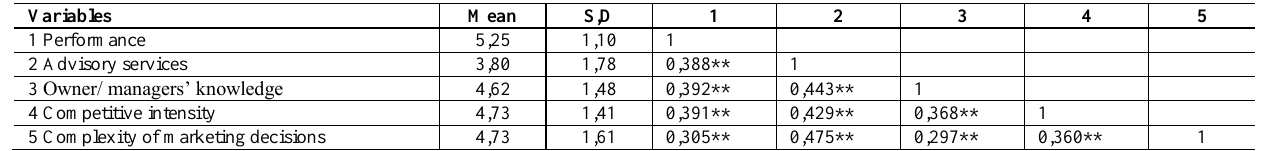
Table 2: Descriptive statistics and correlations Variables